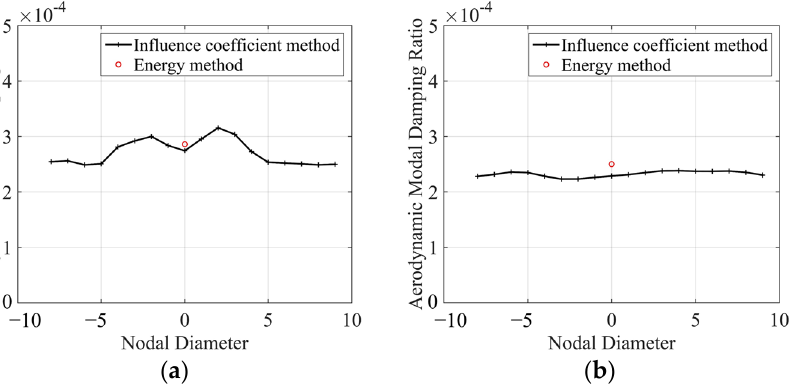
Figure 9. Calculated by the influence coefficient method and the energy method: ( a ) First mode; ( b ) Second mode.